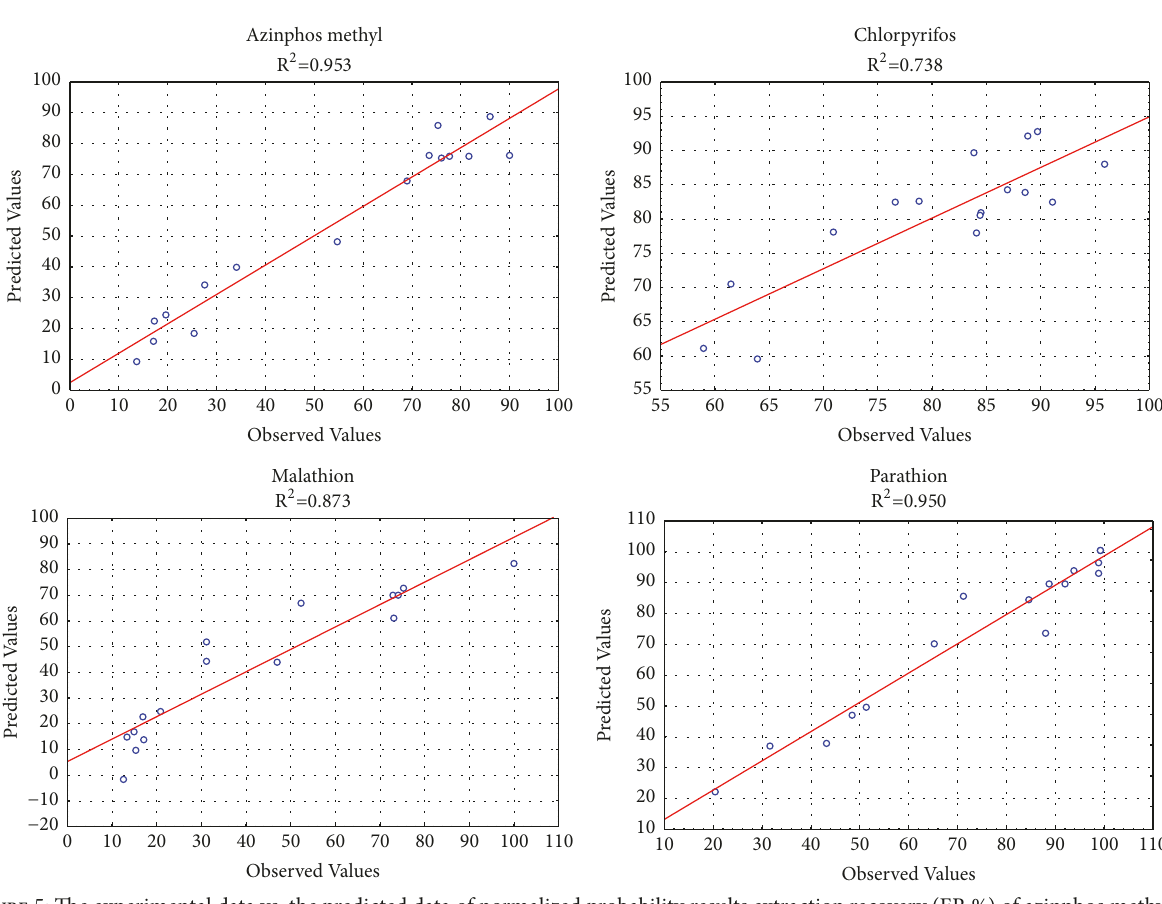
Figure 5: The experimental data vs. the predicted data of normalized probability results extraction recovery (ER %) of azinphos methyl (a), chlorpyrifos (b), malathion (c), and parathion (d). Table 2: The analytical performance of MSPE-LC-MS method for determination of